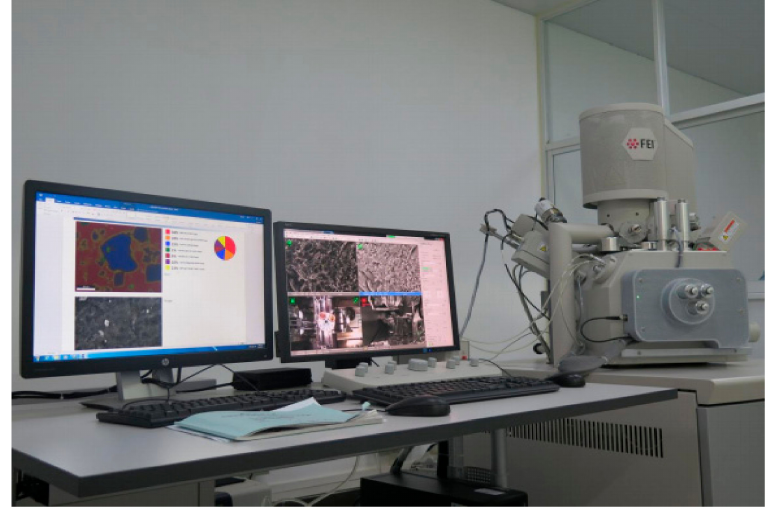
Figure 8. FEI Quanta 650 FEG field emission scanning electron